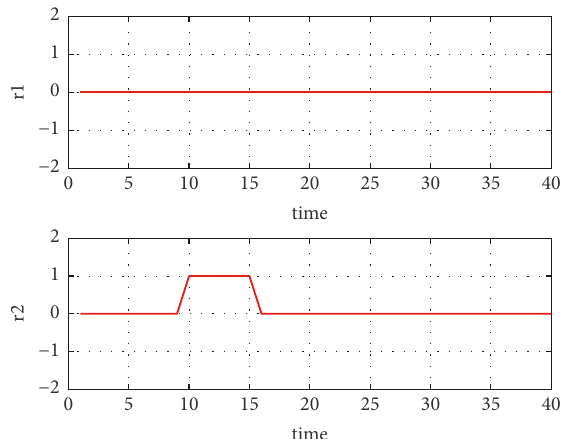
Figure 13: Normalized residue for intermittent fault in IEMG2